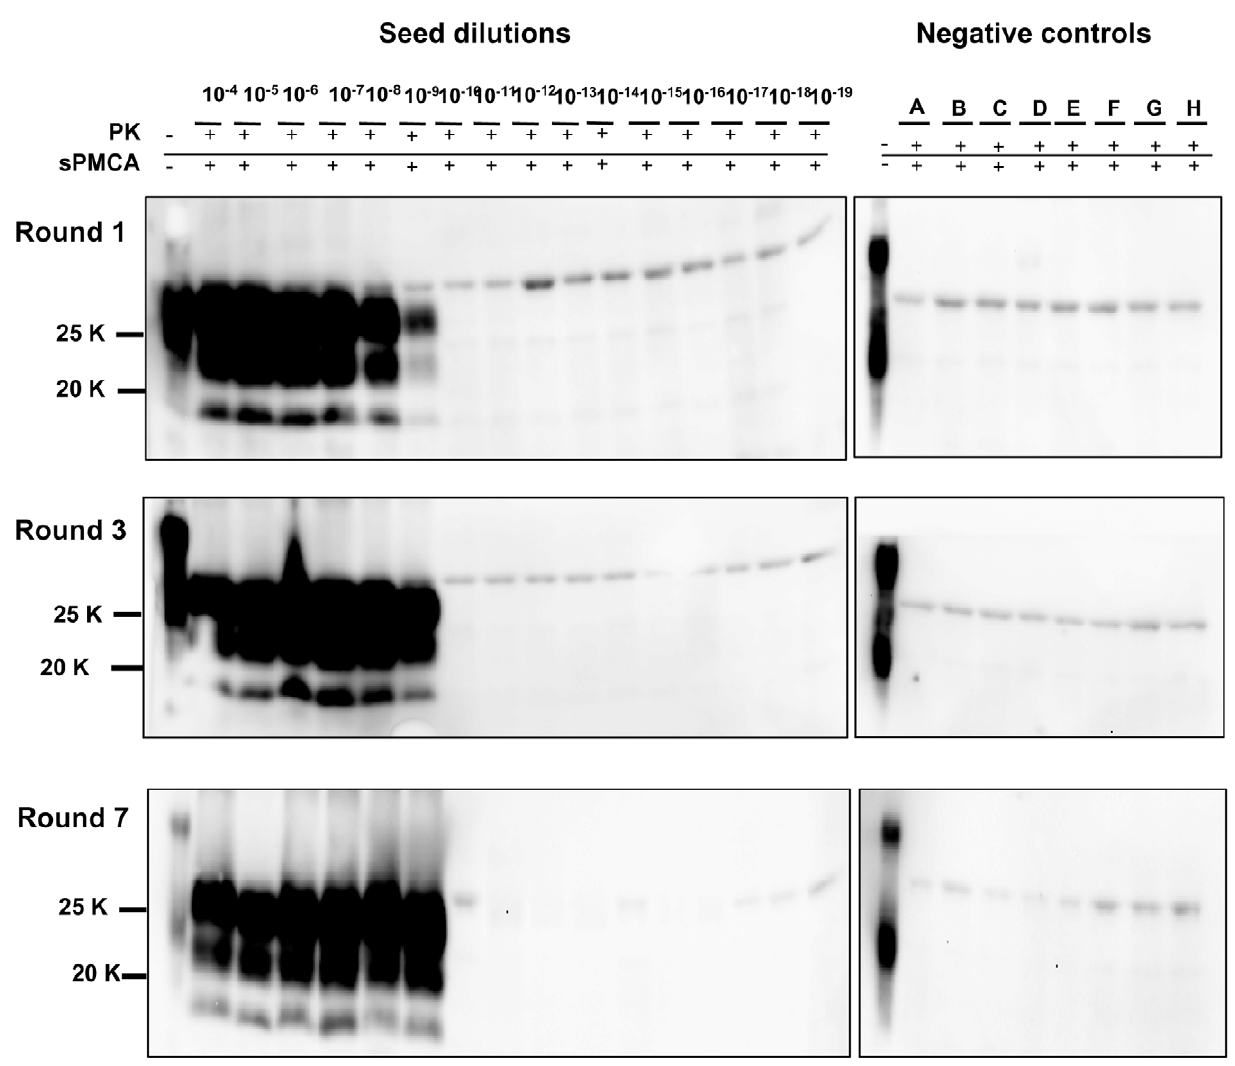
Figure 5. Limit of detection of v586 using saPMCA. Logarithmic dilutions of v586 seed from 10 2 3 to 10 2 18 were prepared using M109M vole substrate. and were amplified for 7 consecutive 48-hour rounds of saPMCA (=96 cycles of incubation/sonication), together with 8 unseeded negative controls (A to H). Positive amplification reached 10 2 9 dilution after the 1 st round. In the subsequent rounds all dilutions up to 10 2 9 continued to be positive while negative controls and dilutions from 10 2 10 to 10 2 18 remained negative. Western blot was stained with SAF84 primary